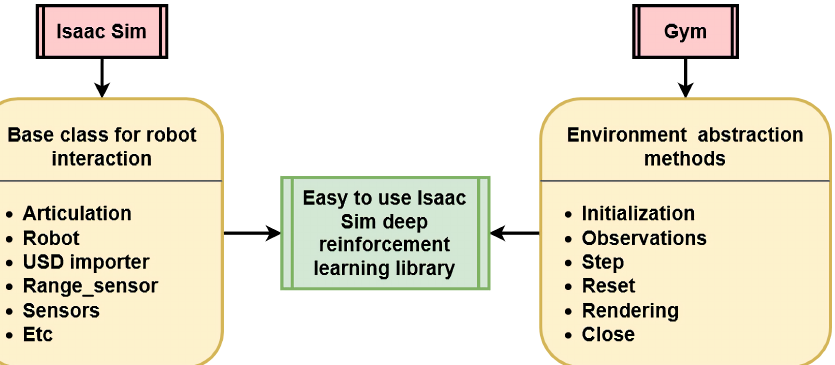
Figure 2. Combination of the different functionalities of Gym and Isaac Sim extensions to create a new